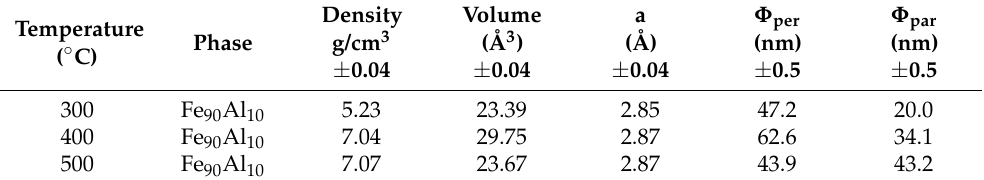
Figure 9. XRD of the sintered Nd 2 Fe 14 B/Fe 90 Al 10 systems at 300, 400 and 500 ◦ C, respectively. Table 7. XRD parameters of the sintered Nd 2 Fe 14 B/Fe 90 Al 10 system at 300, 400 and 500 ◦ C, respectively. Table 8. Mössbauer parameters of the sintered Nd 2 Fe 14 B/Fe 90 Al 10 system for one hour at 300 °C.